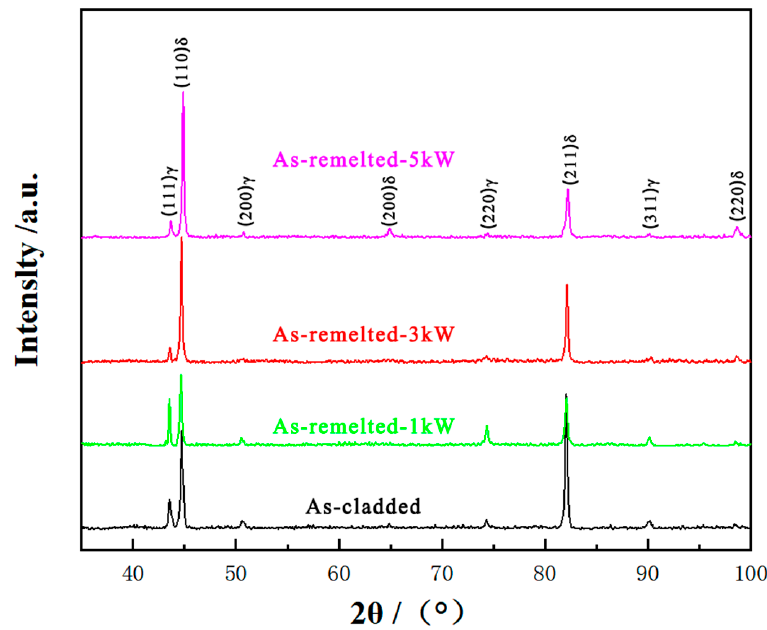
Figure 5. X-ray as-cladded and as-remelted coatings.